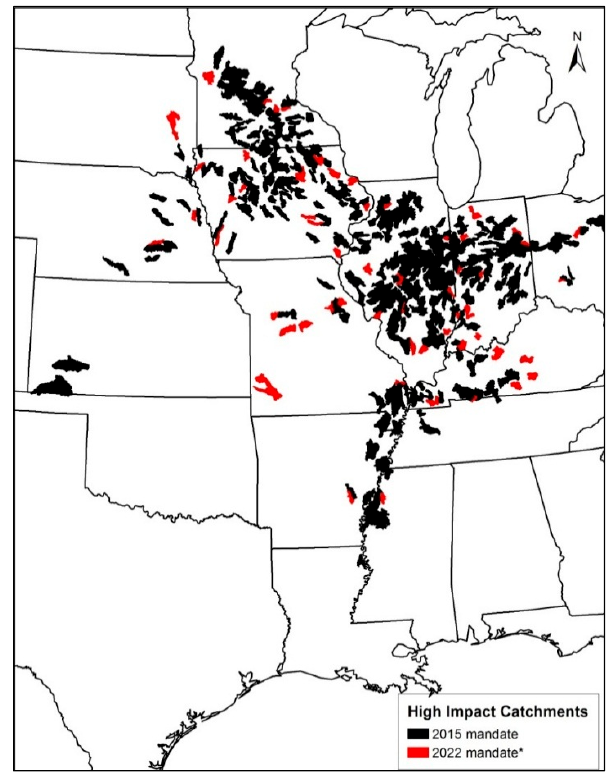
Figure 6. High impact catchment areas. * Additional areas required by the 2022 mandate.